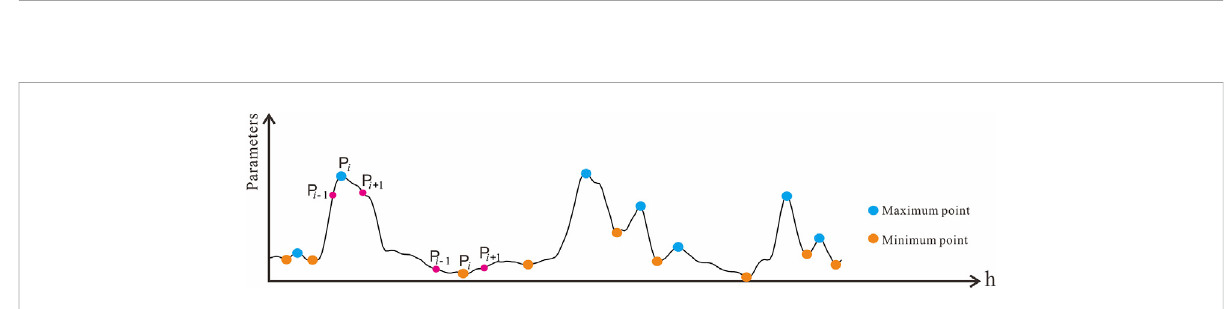
FIGURE 4 Sketch map showing sampling points for complex lithology of transitional shale